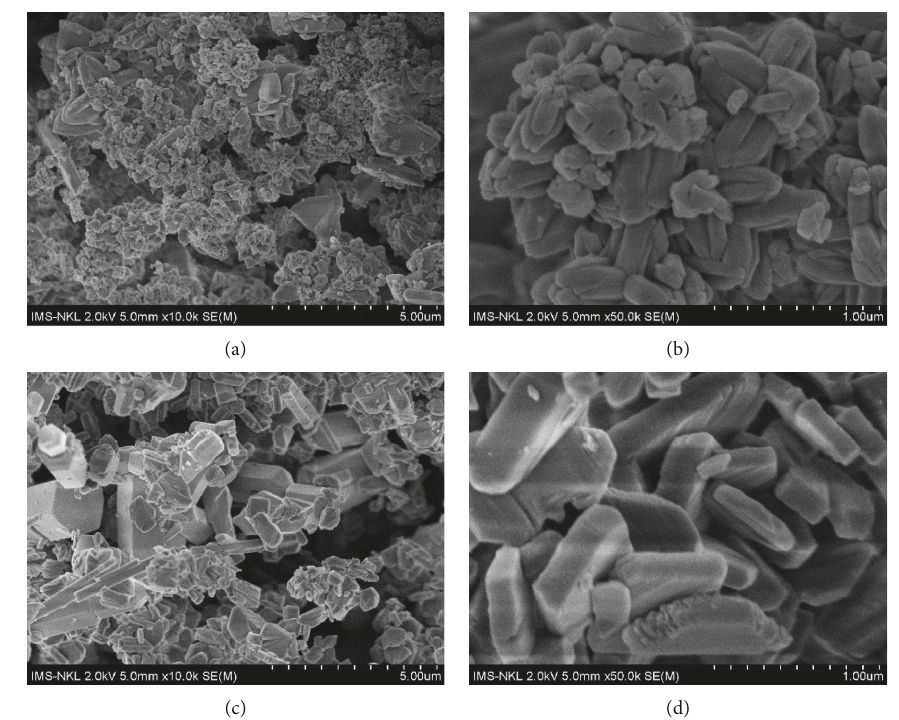
Figure 5: SEM of ZIF-8 synthesized in water: process A (a, b); process B (c,